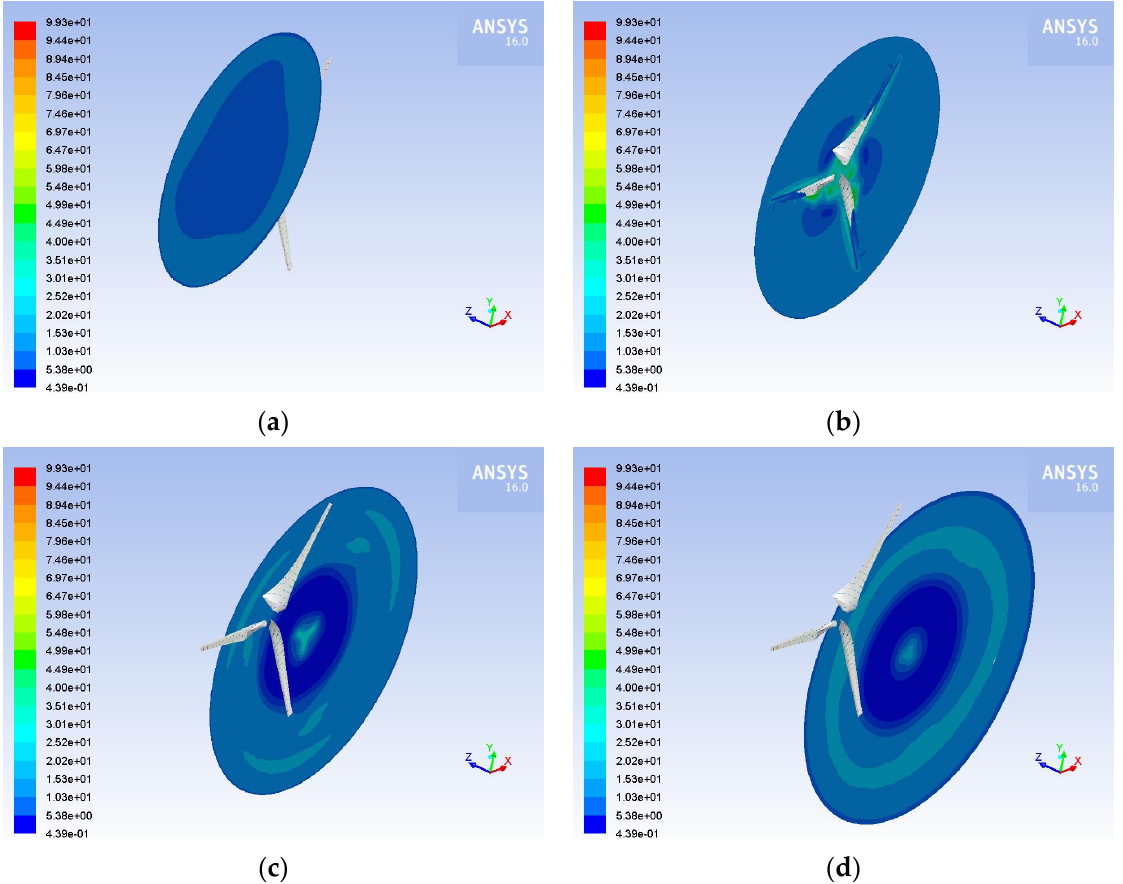
Figure 6. Contours of velocity at ( a ) − 15 m; ( b ) 0 m; ( c ) 15 m; ( d ) 30 m from the three-bladed HAWT rotor for airflow and air velocity equal to 15 m · s − 1 .